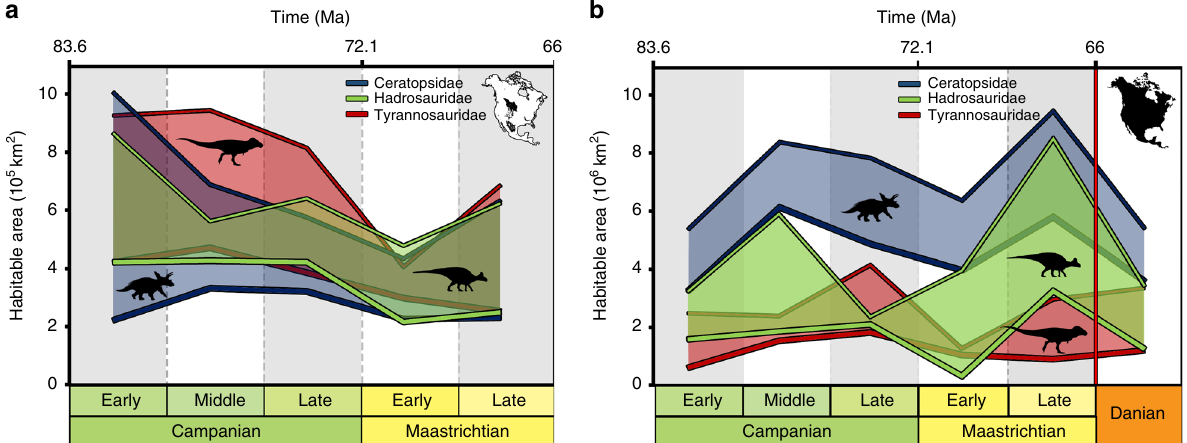
Fig. 4 Time-bin quanti fi cation of habitat suitability of ecological niche models. Quanti fi cation is shown for only outcrop area ( a ) and for the whole latest Cretaceous North American palaeocontinent ( b ). Both sets of models have been trained with the same extent (outcrop area), but while a shows quanti fi cation in training region, plot in b shows original models projected to North America. Thick line represents higher suitability threshold quanti fi cation (>0.7), while thinner line is lower suitability threshold one (>0.45). An overall decrease in habitat suitability in available outcrop areas is shown in a while an increase is obtained for all the three clades in North America ( b ). Orange column in b represents habitat stability when niche models are projected after the K/Pg boundary, showing potential habitability for these clades after the end-Cretaceous mass extinction. Numeric values on the y -axes are in 10 5 km 2 in a and 10 6 km 2 in b . Numeric values to build this fi gure are in Supplementary Table 1 and Supplementary Table 2. Tyrannosauridae silhouette by Jack Mayer Wood (CC BY 3.0 license: https://creativecommons.org/licenses/by/3.0/ CC BY 3.0); Hadrosauridae silhouette by Pete Buchholz (under CC BY-SA